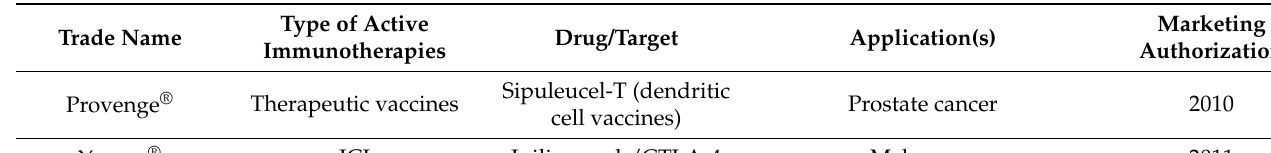
Table 3. Anticancer active immunotherapies currently approved by the FDA and/or EMA. * orphan drug